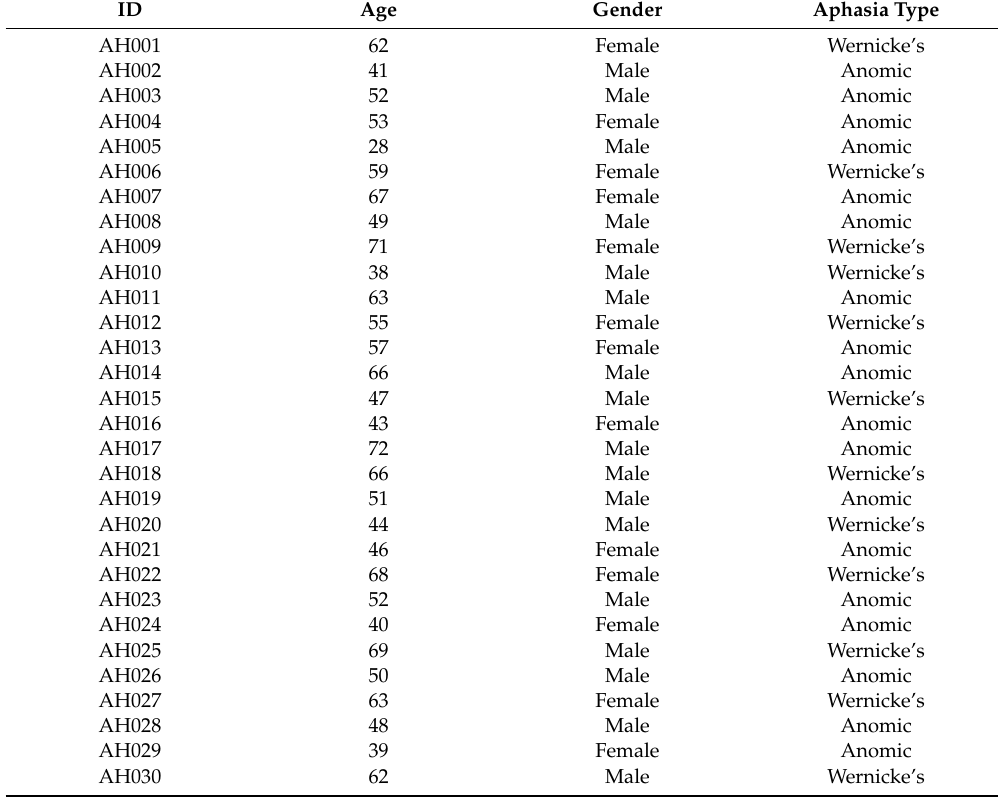
Table 1. Participants’ demographic data and initial clinical